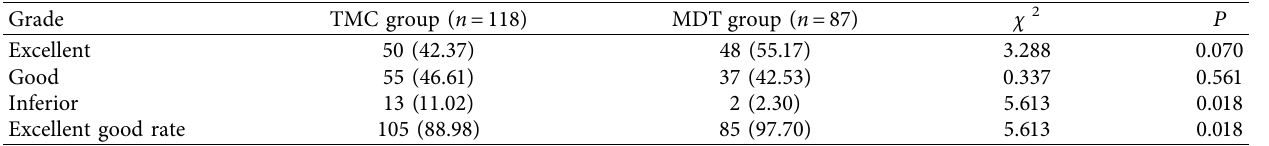
Figure 3: Postoperative outcome indicators. Note: (a) Mortality and disability rate (%), (b) scores for each scale (scores). Comparison of same outcome indicators between groups, ∗ P < 0 . 05. Table 2: Treatment compliance.